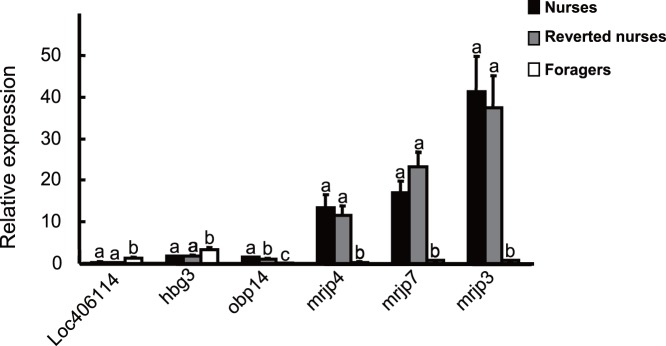
Verification of six differentially expressed genes between forager/nurse and reverted nurse/forager comparisons by quantitative RT-PCR.Different letters on top of bars indicate significant difference (P<0.05) with Fisher’s Protected Least Significant Difference. Each bar corresponds to a single group represented as the mean ± S.E. of its biological replicates. All six genes showed significant differences in gene expression level between forager/nurse and reverted nurse/forager comparisons by t-test.